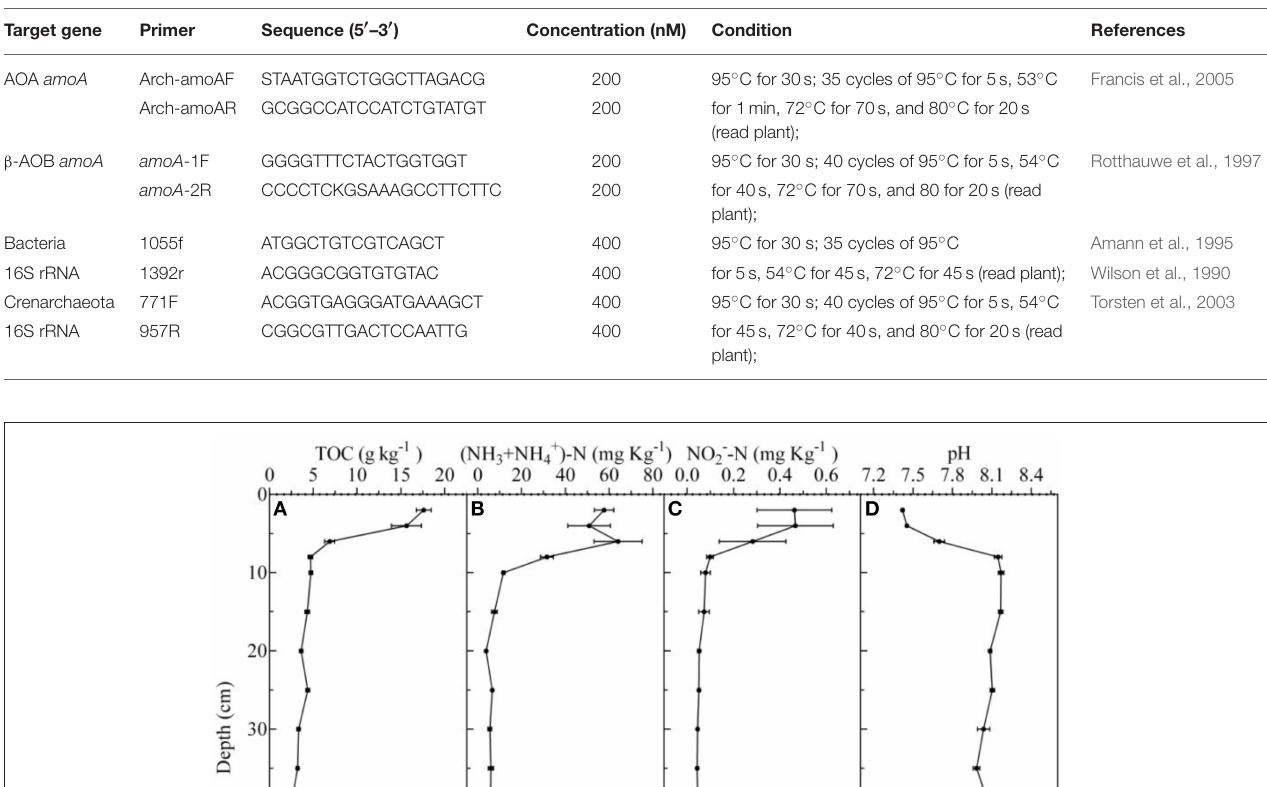
factors and the amoA gene abundance of the AOA and